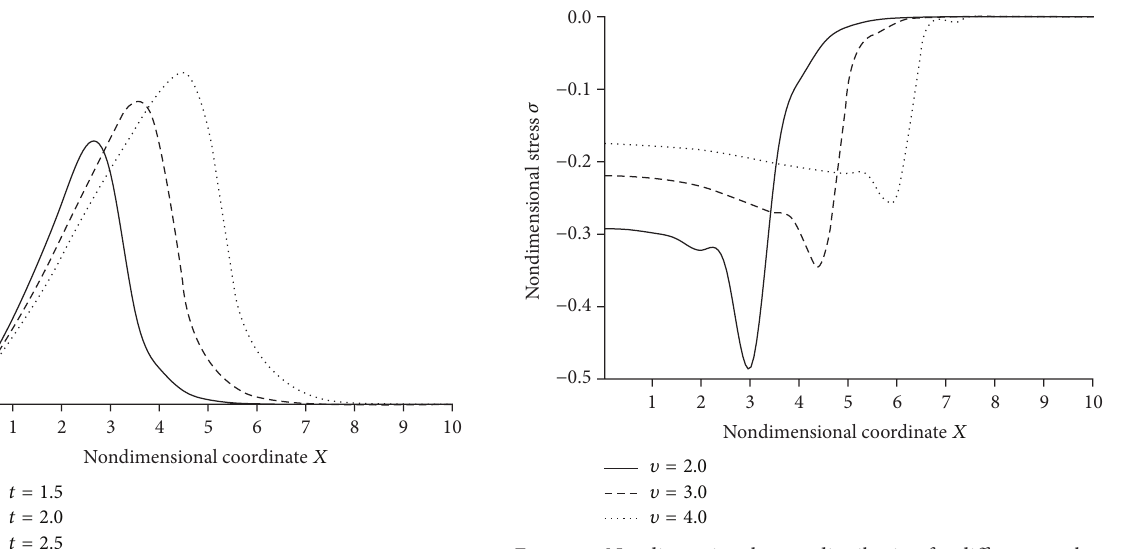
Figure 5: Nondimensional stress distribution for different 𝜐